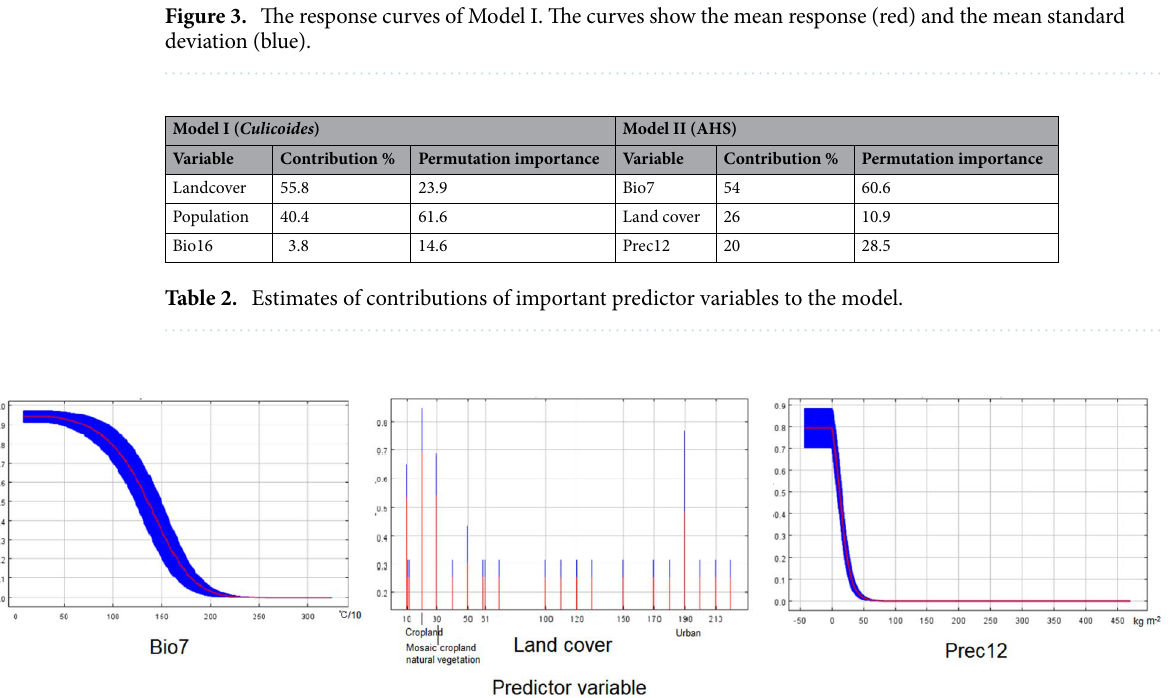
Figure 4. The response curves of Model II. The curves show the mean response (red) and the mean standard deviation